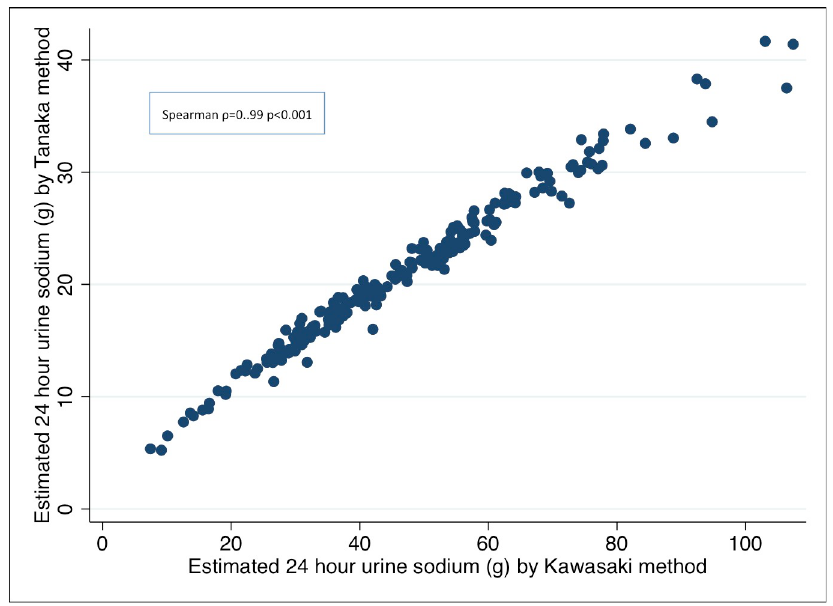
Fig 2. Correlation between the Tanaka and Kawasaki methods for estimation of 24-hour urine sodium from a single spot urine sample.